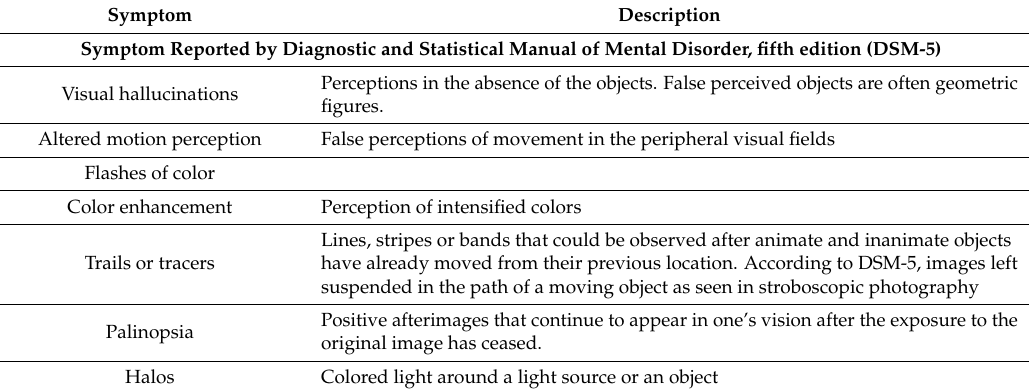
Table 2. A representative, but not exhaustive, list of reported visual